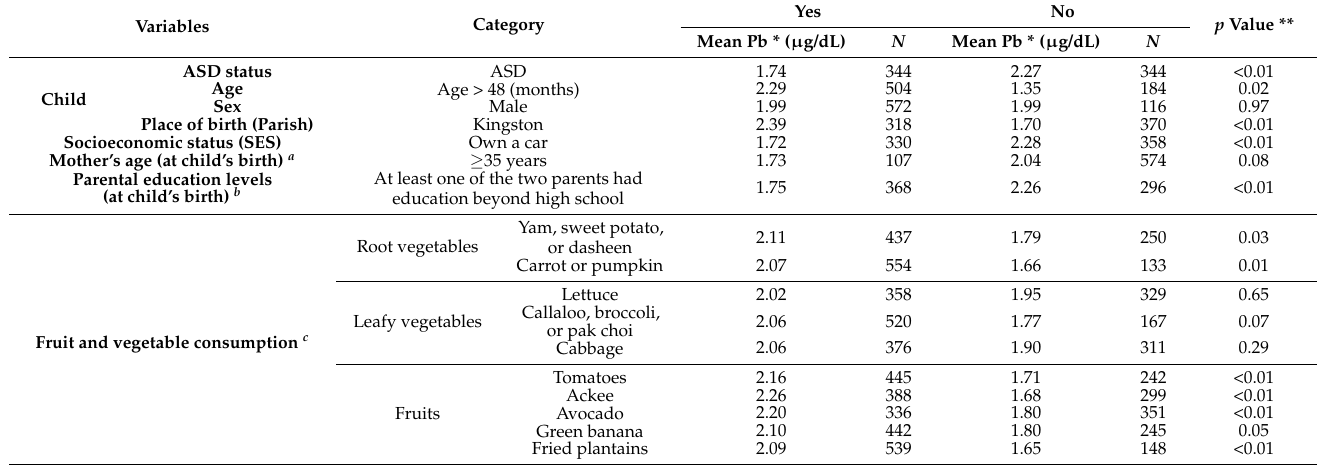
Table 3. Findings from univariable general linear models that assess associations of various inde- pendent variables with blood Pb concentrations (344 matched pairs) of Jamaican children (total n =